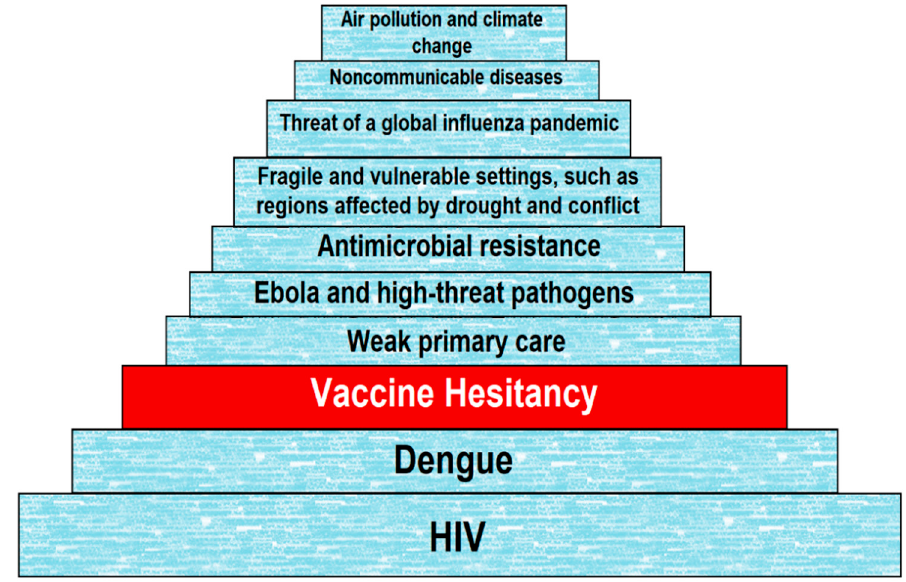
Figure 1. Top ten (10) threats to global health in 2019 according to the World Health Organization